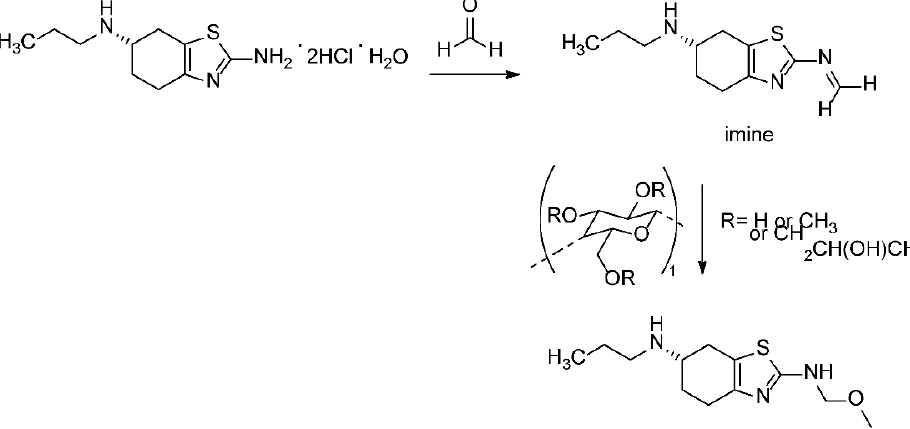
Figure 7 . Chemical structure of the pramipexole imine related compound.